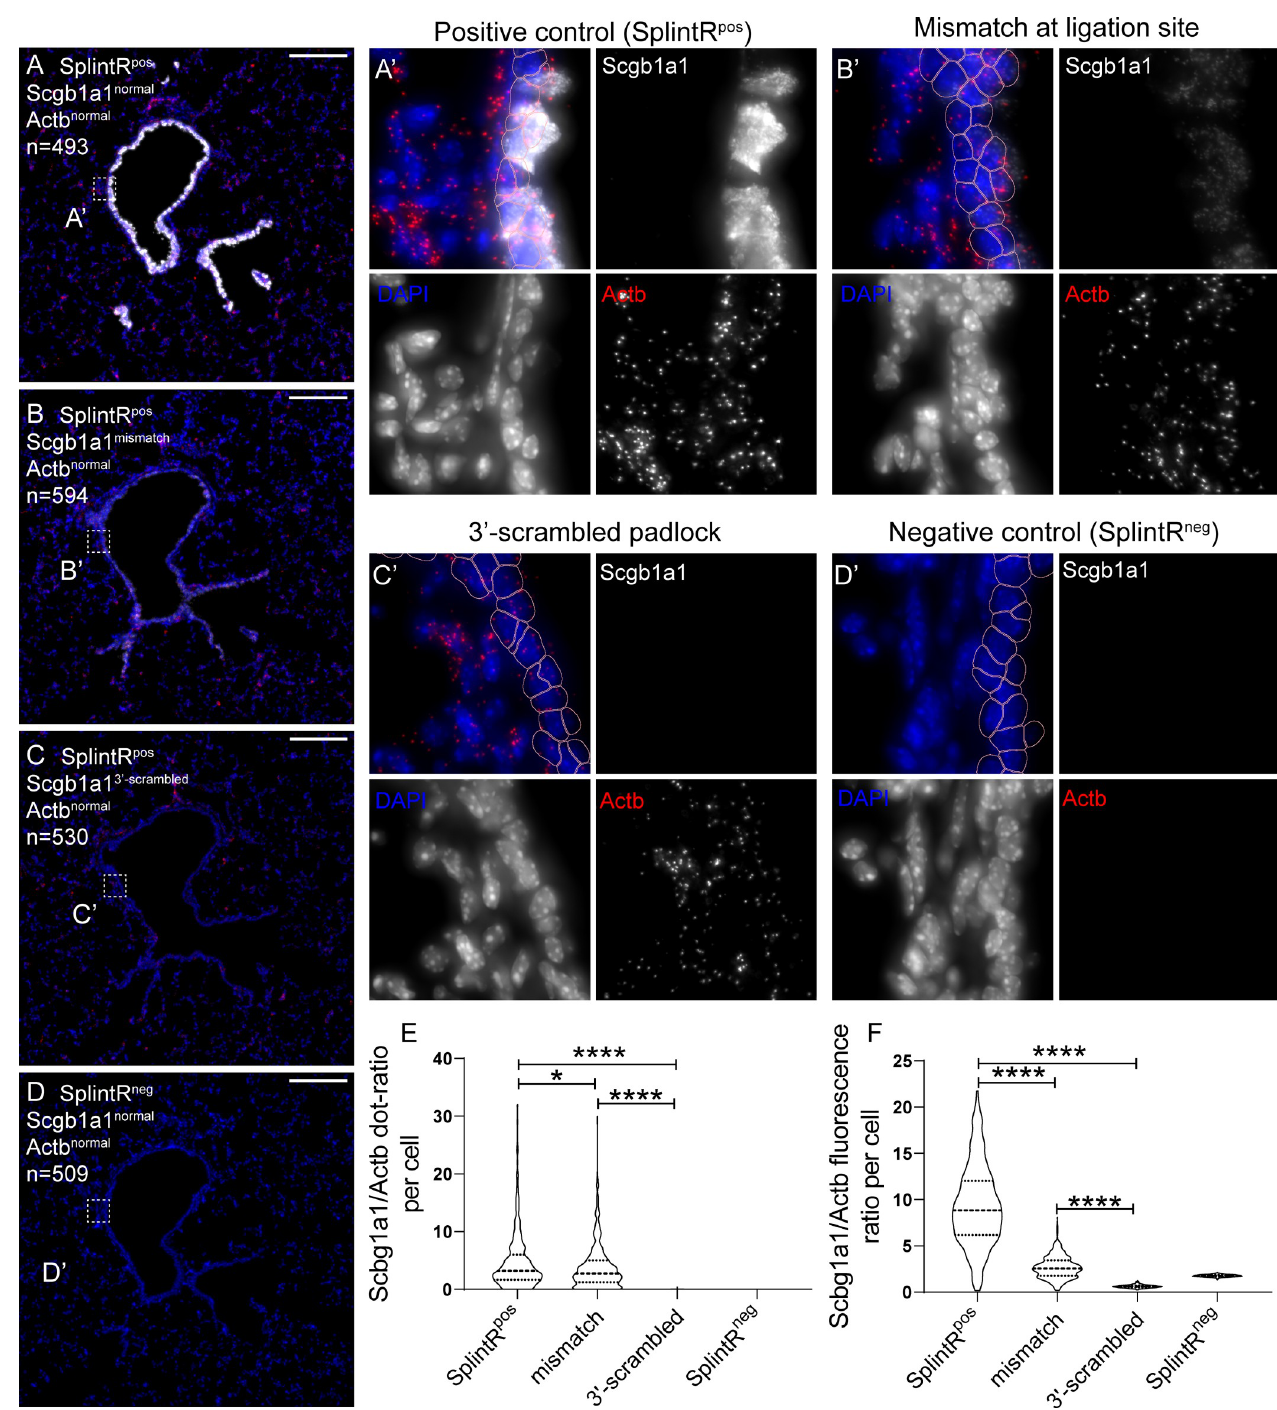
Fig 2. SCRINSHOT specificity relies on stringent hybridization of padlock probes to their target RNAs. Images of SCRINSHOT signal, using normal Scgb1a1 padlock probe (A), a Scgb1a1 padlock probe with a point mutation at its ligation site (B), a Scgb1a1 padlock probe with 3 0 -scrambled arm (C) and normal padlock probe but omitting SplintR ligase (D). Actb normal padlock probe was used in all conditions as internal control. DAPI: blue, Scgb1a1 : gray, Actb : red. “n” indicates the number of airway cells in the corresponding images. (A’-D’) Magnified areas of the indicated positions (square brackets) of images in the left. Pink outlines show the 2- μ m expanded airway nuclear ROIs, which are considered as cells. Scale bar: 150 μ m. (E) Violin plot of the Scgb1a1 and Actb signal dots ratio in all airway cells. The ratio of cells with zero Actb -dots was considered as zero. There were no statistically significant differences for Actb signal dots, between the analyzed conditions, except for the SplinR neg , that gave no signal, as expected, indicating that ligation is obligatory for signal detection ( P